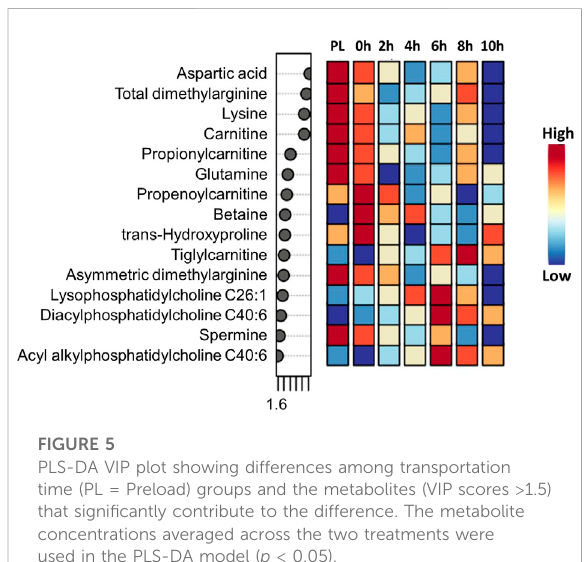
FIGURE 5 PLS-DA VIP plot showing differences among transportation time (PL = Preload) groups and the metabolites (VIP scores > 1.5) that signi fi cantly contribute to the difference. The metabolite concentrations averaged across the two treatments were used in the PLS-DA model ( p <